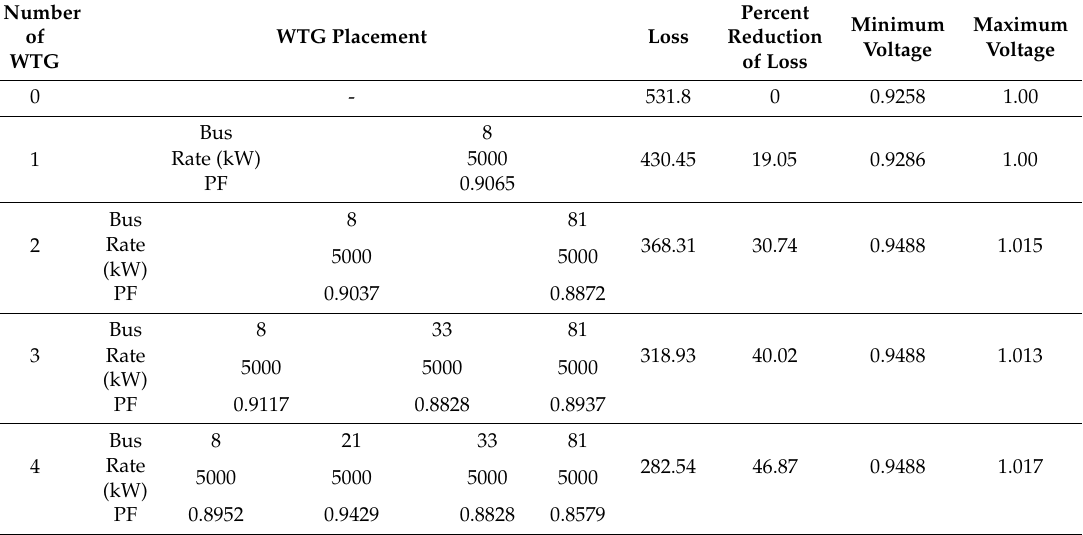
Table 1. This Results of optimal turbine site selection without considering constraints (single-objective).